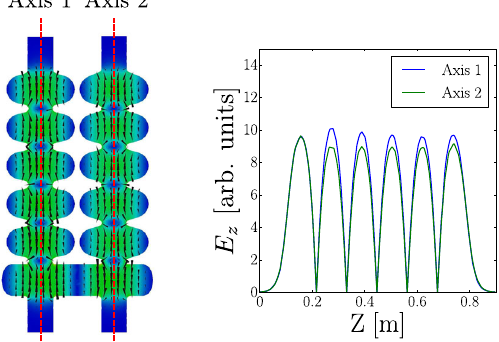
FIG. 8. A contour plot of the electric field distribution for the operating mode (left) and the electric field along each